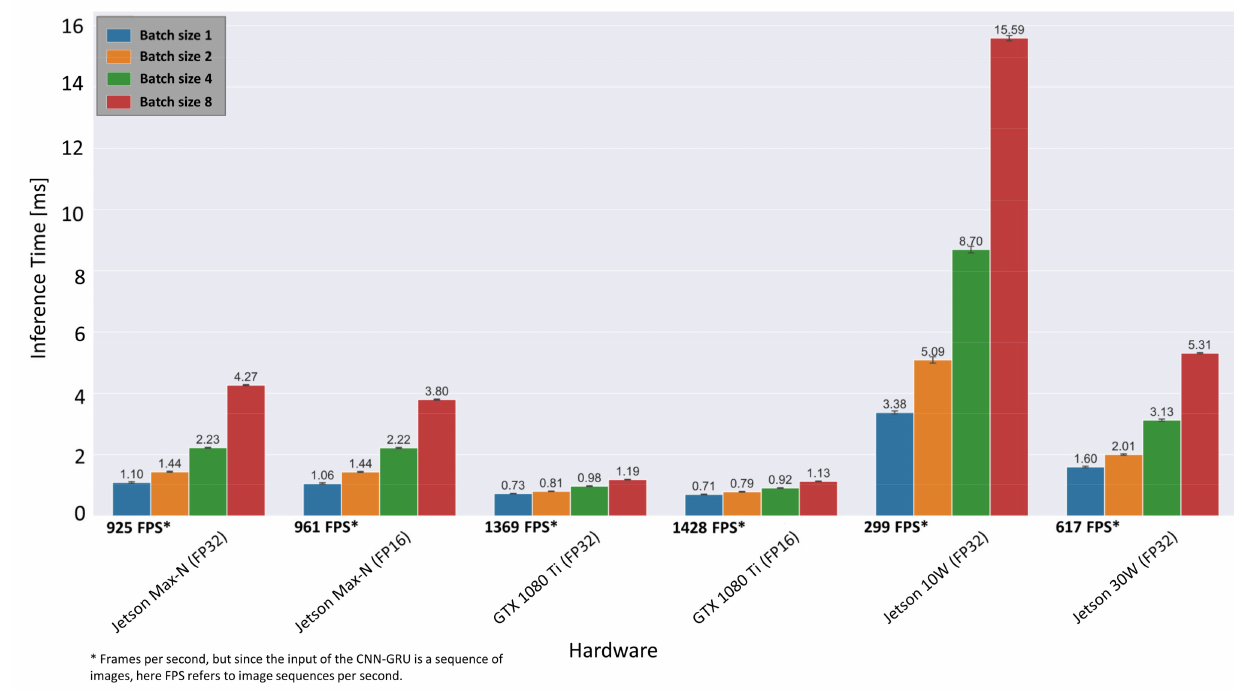
Figure 14. Inference results of the CNN-GRU architecture after optimization via TensorRT for different hardware